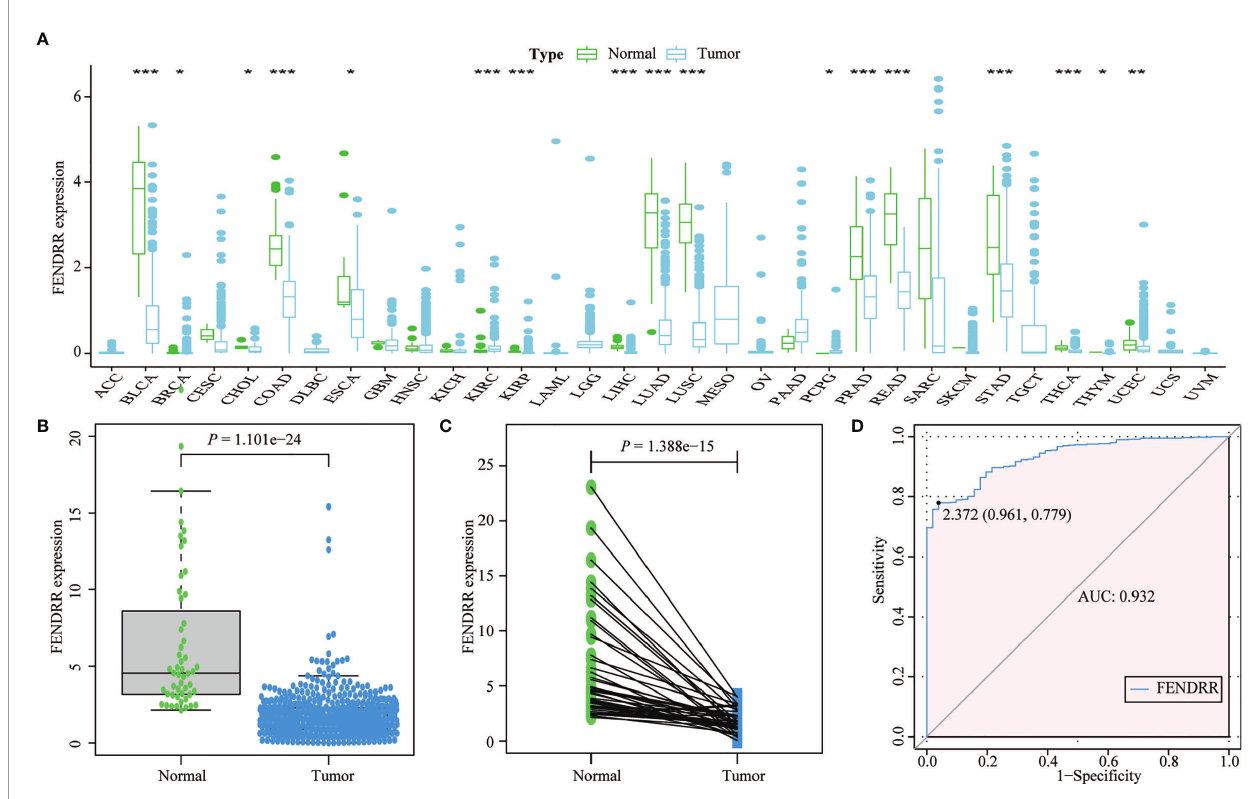
FIGURE 2 | Fetal-lethal non-coding developmental regulatory RNA (FENDRR) expression in patients with colon adenocarcinoma/rectum adenocarcinoma (COAD/ READ). (A) FENDRR expression in 33 tumor types and adjacent healthy tissues. (B) FENDRR expression in tumors and adjacent healthy tissues. (C) FENDRR expression in tumors and matched adjacent healthy tissues. (D) Receiver operating characteristic (ROC) curve analysis of FENDRR expression in tumors and adjacent healthy tissues. *, **, ***, indicate signi fi cance at p < 0.05, p < 0.01 and p < 0.001,